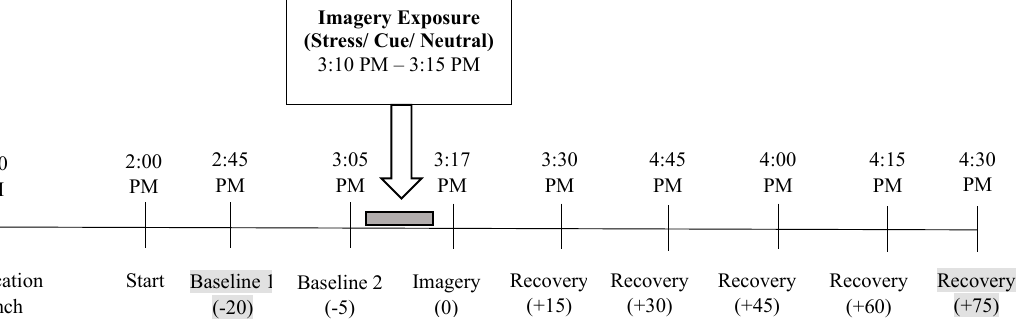
Figure 1. Schematic illustration of the laboratory sessions conducted on separate days, with order of imagery condition randomized and counter balanced. Participants self-administered study medication at 1:00 p.m. on each day prior to the experimental sessions. Cocaine craving and anxiety ratings, heart rate (HR), and systolic (SBP) and diastolic blood pressure (DBP), were collected at baseline ( − 20 and − 5 min prior to imagery), immediately following imagery presentation (0) and every 15 min after the imagery period, up to 75 min (+15, +30, +45, +60, +75). Blood samples, highlighted in grey, to assess pregnenolone levels were collected at baseline ( − 20 min) and at the last timepoint (+75